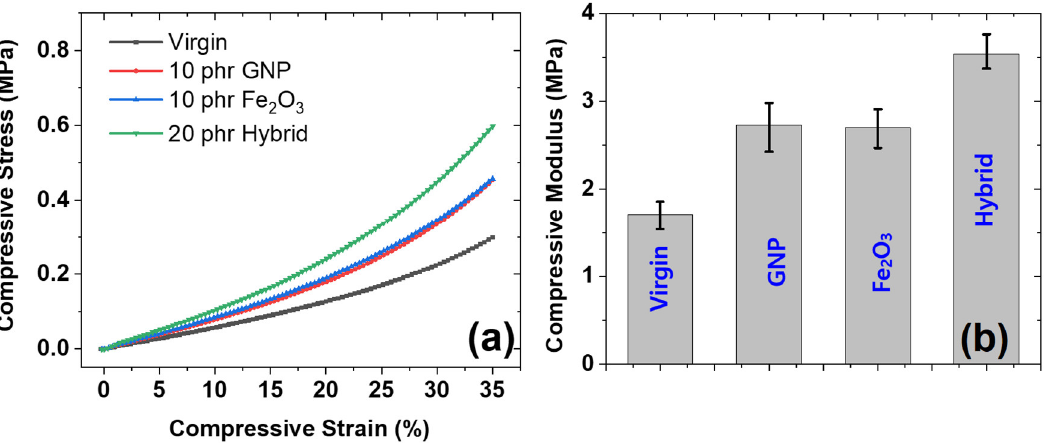
Figure 5. Compressive mechanical properties; ( a ) compressive stress–strain of the composites, ( b ) compressive modulus of different composites. ( b ) compressive modulus of different